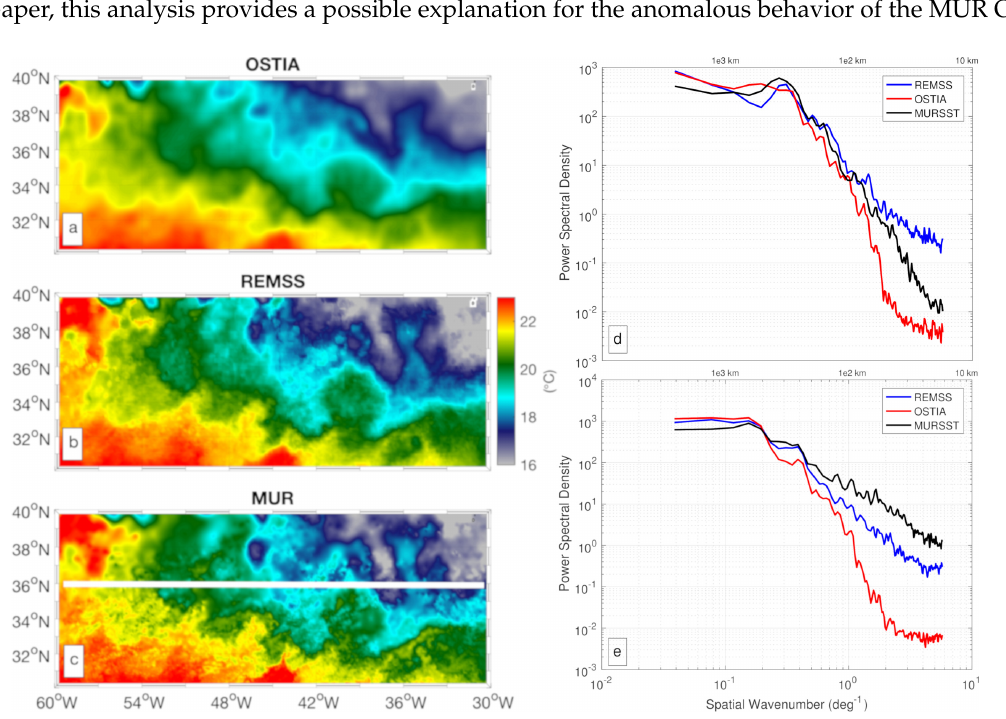
Figure 5. Left: ( a ) OSTIA, ( b ) REMSS and ( c ) MUR SST, 1 January 2016, North Atlantic. Right: Corresponding mean zonal spatial spectra. ( d ) Northern box (36 ◦ N to 40 ◦ N), ( e ) Southern box (30 ◦ N to 36 ◦ N) (the x axis is also expressed in km). The white line is referenced in Section